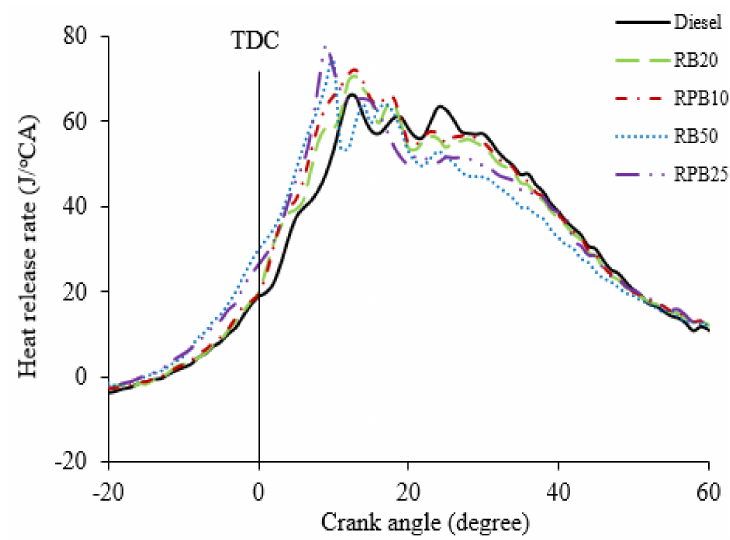
Figure 5. Variation of HRR at 2000 rpm at full